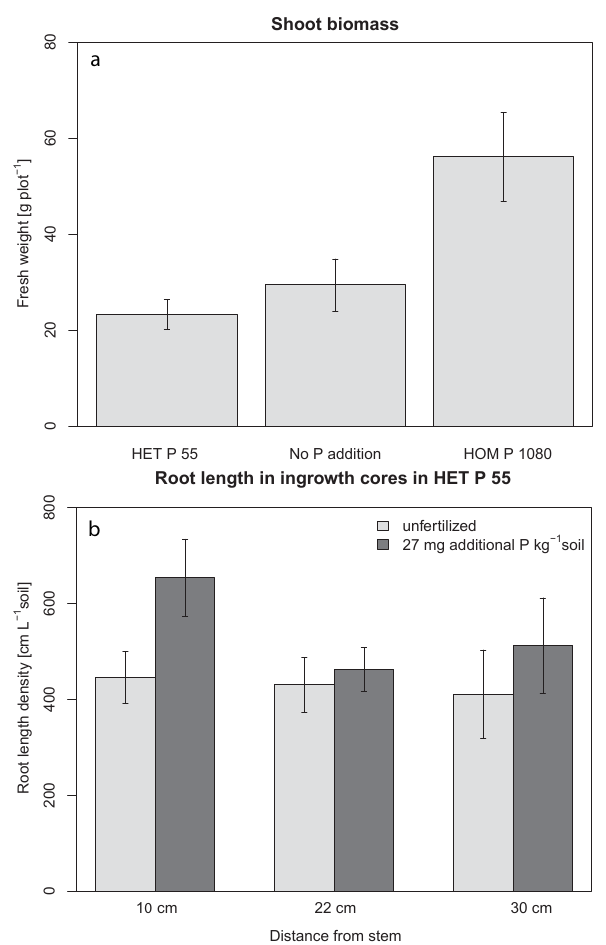
Fig. 3. (a) Shoot fresh weight production of single field-grown L. corniculatus plants grown on plots with heterogeneous P fertil- ization (HET P 55), no P addition (No P addition) or homogeneous P fertilization (HOM P 1080). (b) Root length density in fertilized and unfertilized ingrowth cores of HET P 55 at 10, 22 and 30cm from the stem of the plants. Error bars refer to the standard error of the mean. P fertilization and distance had a significant effect on root length density in the ingrowth cores (2-way-ANOVA, p < 0 . 05).